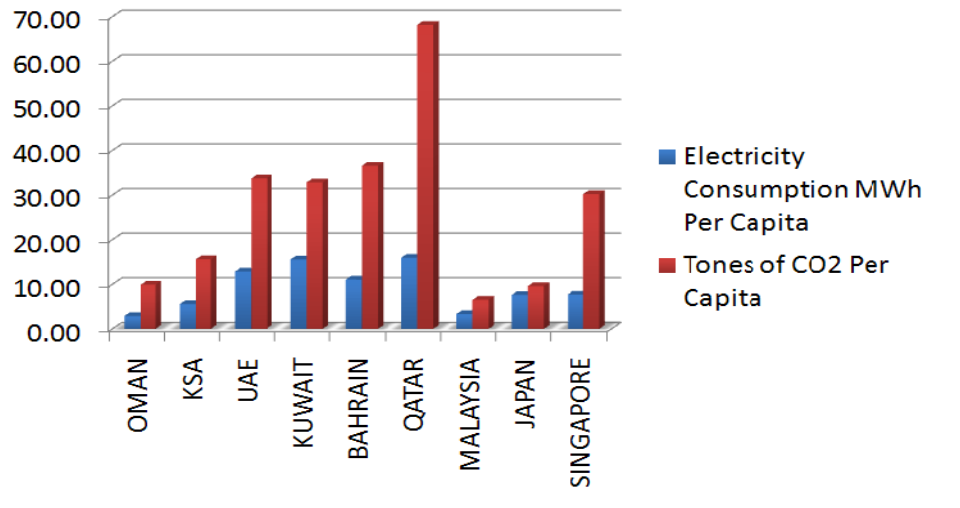
Figure 10. Year 2005–GCC–pro-capite Electricity Consumption and GHG